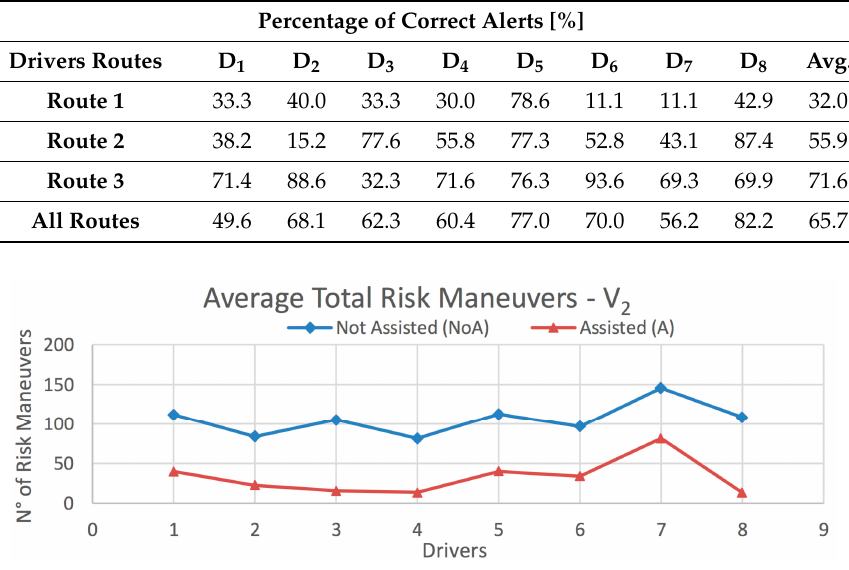
Figure 15. Average total risk maneuvers on all routes for V 1 (Light Vehicle). Table 6. Decrement percentage of risky maneuvers for V 1 (Light Vehicle): Route 1, Route 2, Route 3 and all routes.